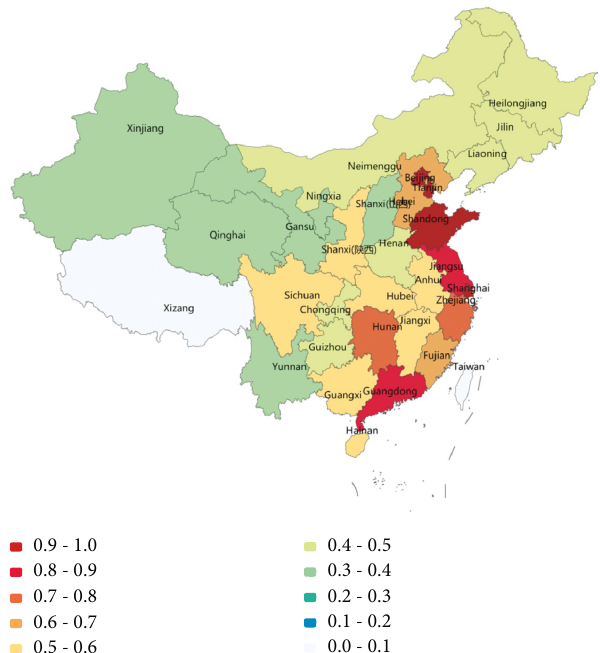
Figure 10: 2016–2020 EEE mean value in